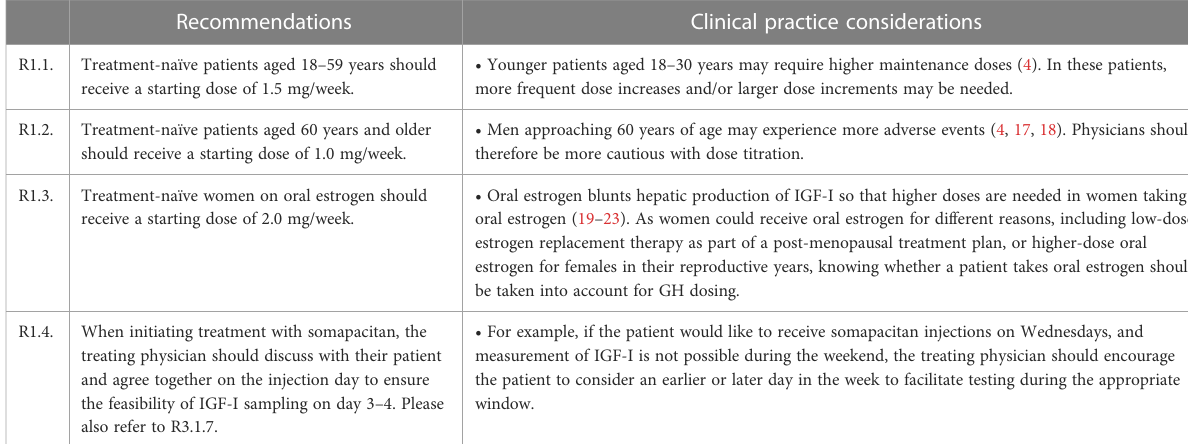
TABLE 1 Recommendations for initiating GH replacement with somapacitan in treatment-naïve patients with AGHD.